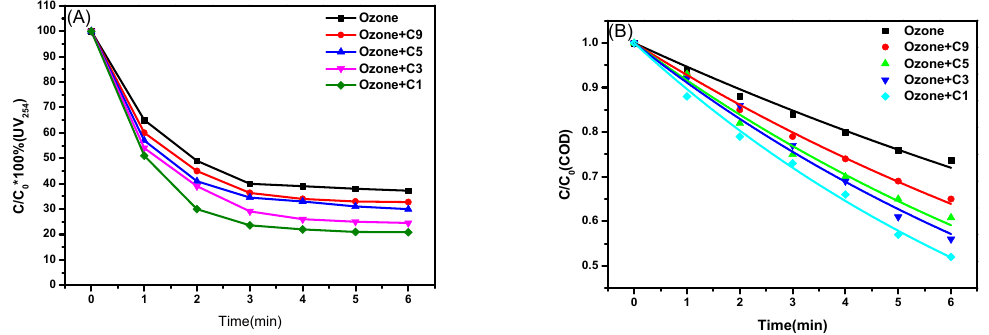
Figure 6. The removal of UV 254 ( A ) and COD ( B ) for the sample A during treatment by O 3 and different size of γ -Al 2 O 3 /O 3 .